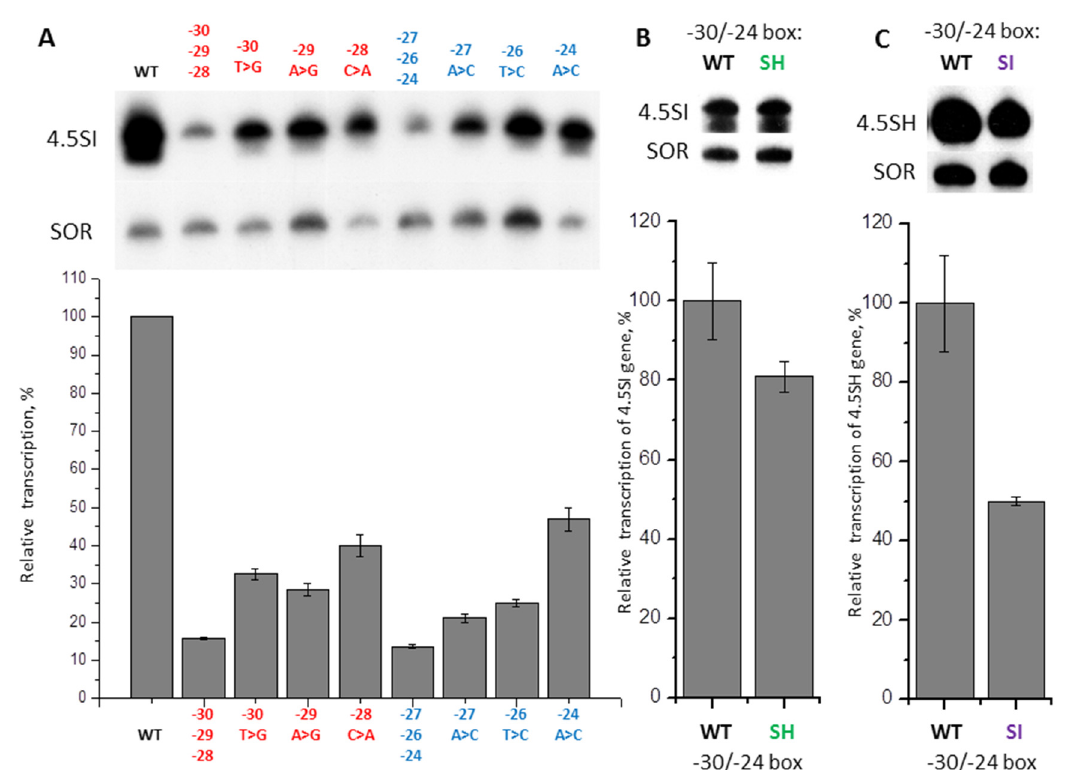
Figure 6. ( A ) Amplification of the effect caused by substitution of nucleotides in box –31/–24 of 4.5SI RNA gene. Upper panel: transcripts of 4.5SI gene detected by Northern hybridization in cells transfected by constructs with substitutions of one or three nucleotides in the left (–30, –29, –28) and in the right (–27, –26, –24) halves of the box. The substitutions and their positions are indicated above the lanes. Lower panel: quantitative analysis of Northern hybridization data. The transcription level of the gene without nucleotide substitutions (WT) is taken as 100% (error bars, SD, n = 3). ( B ) The effect of the –30/–24 sequence replacement in 4.5SI RNA gene by the –30/–24 box from the 4.5SH RNA gene on its transcription. ( C ) The effect of replacement of the –30/–24 sequence in 4.5SH RNA gene by the –30/–24 box from 4.5SI RNA gene on its transcription.